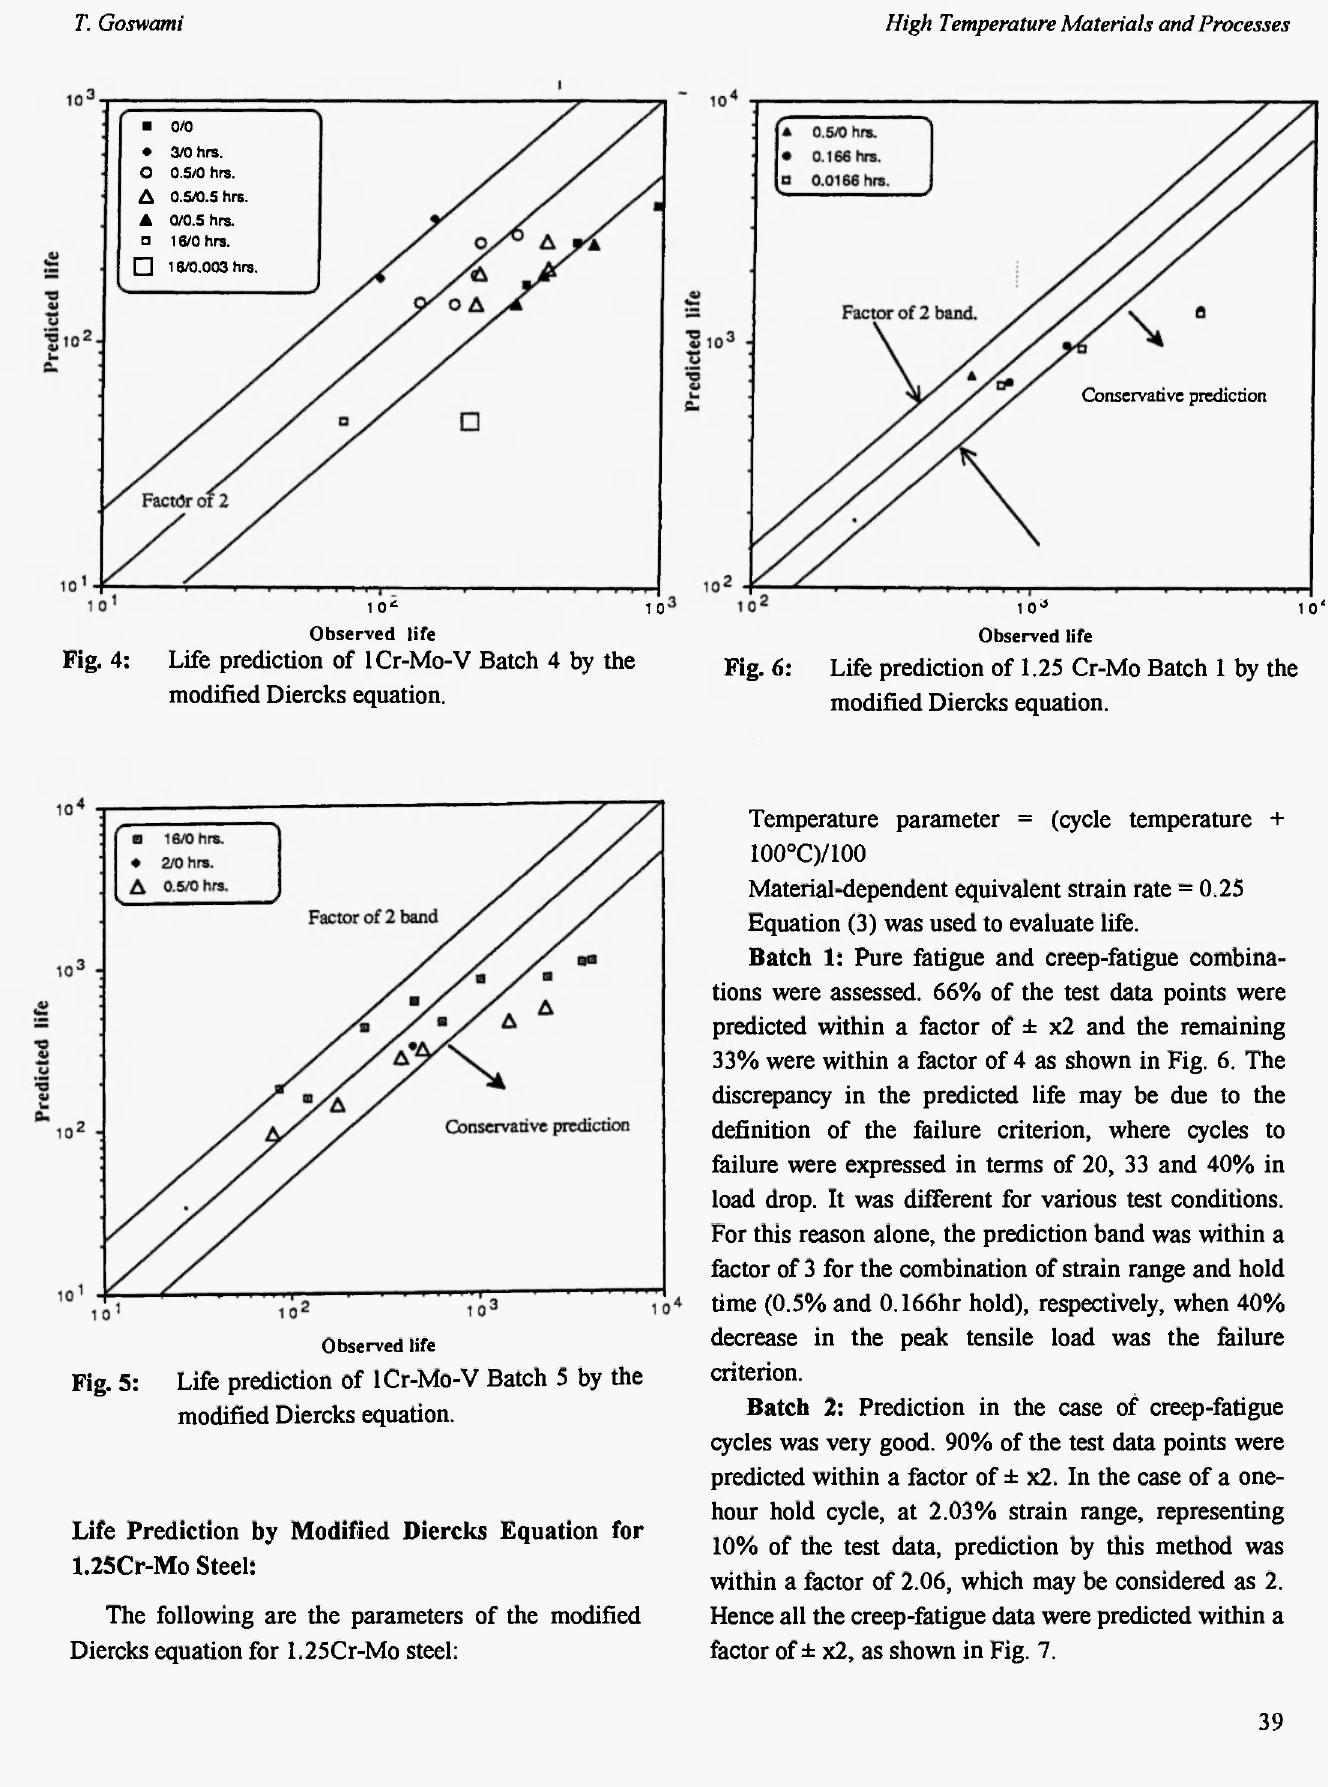
Fig. 4: Life prediction of lCr-Mo-V Batch 4 by the modified Diercks equation.